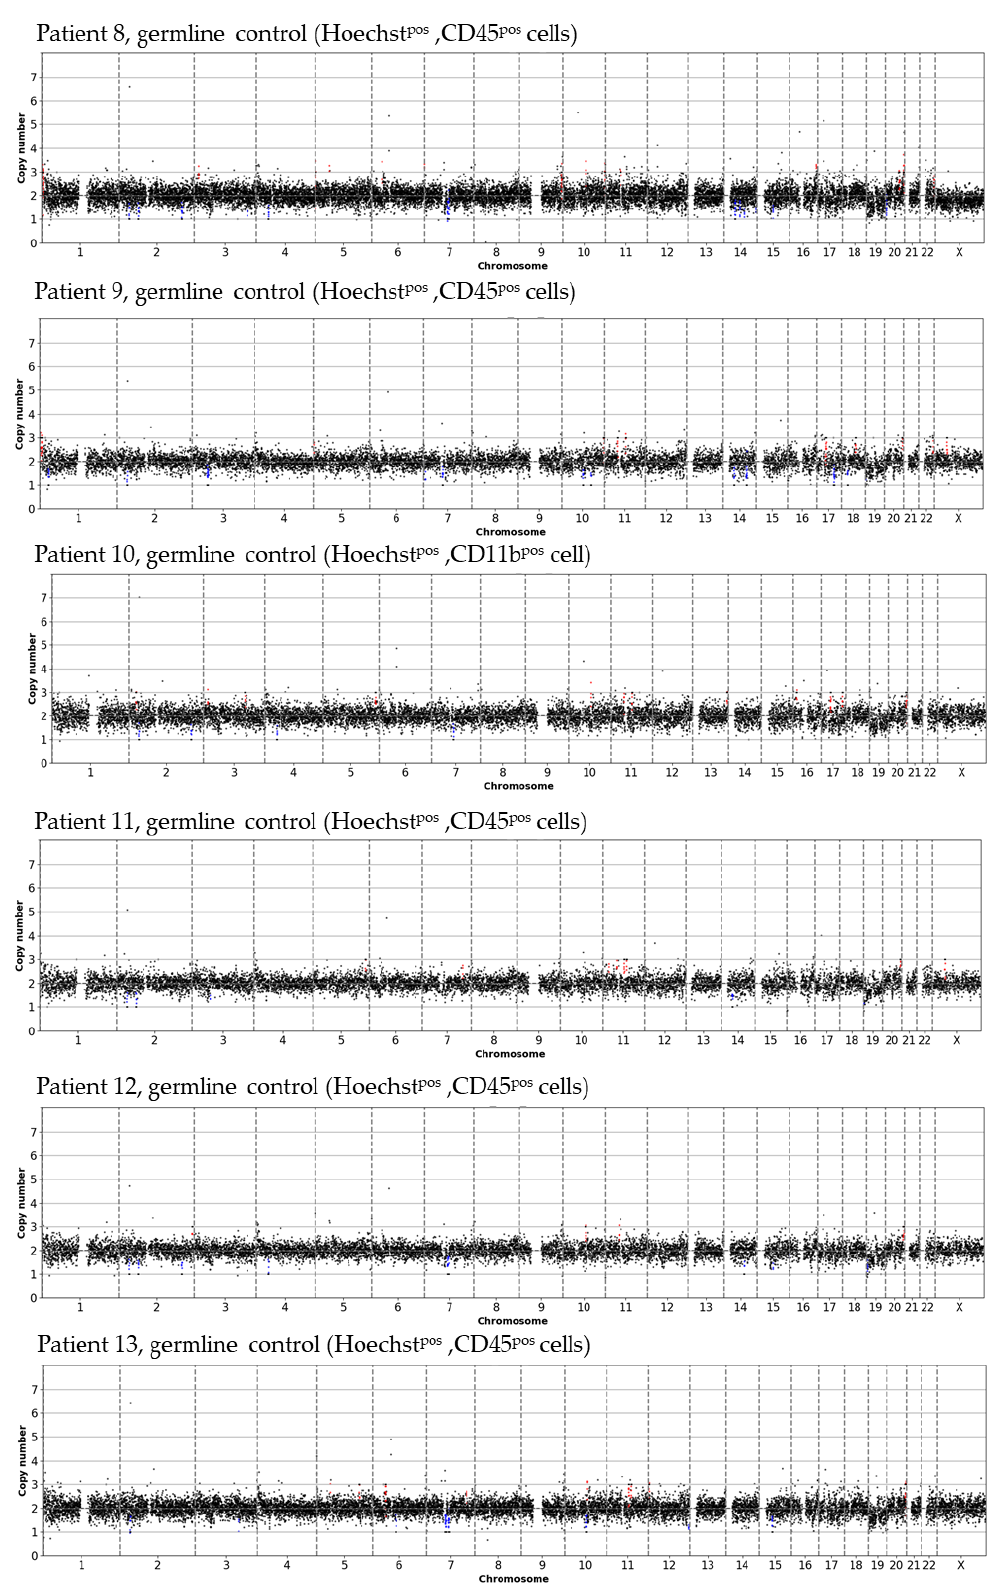
Figure A4. CN profiles of germline samples from all 13 patients. Cells (range 7-10) positive for CD45 and the nucleus counter staining Hoechst were isolated in every patient. For patient 10, the quality of the WGA product was not compatible with the further downstream analysis, therefore, one Hoechst pos and CD11b pos cell was used as a germline